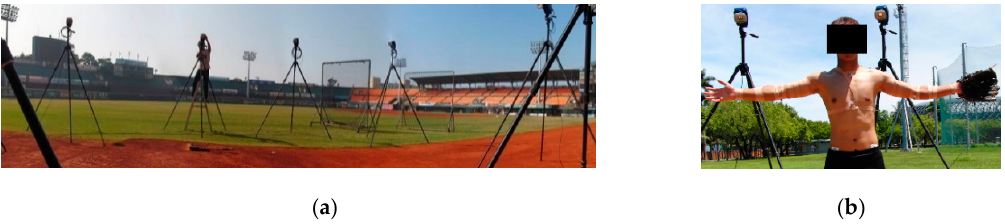
Figure 1. The experimental instrument setting ( a ) cameras setup of the motion capture system in the baseball stadium and ( b ) locations of markers attachments on the subject.